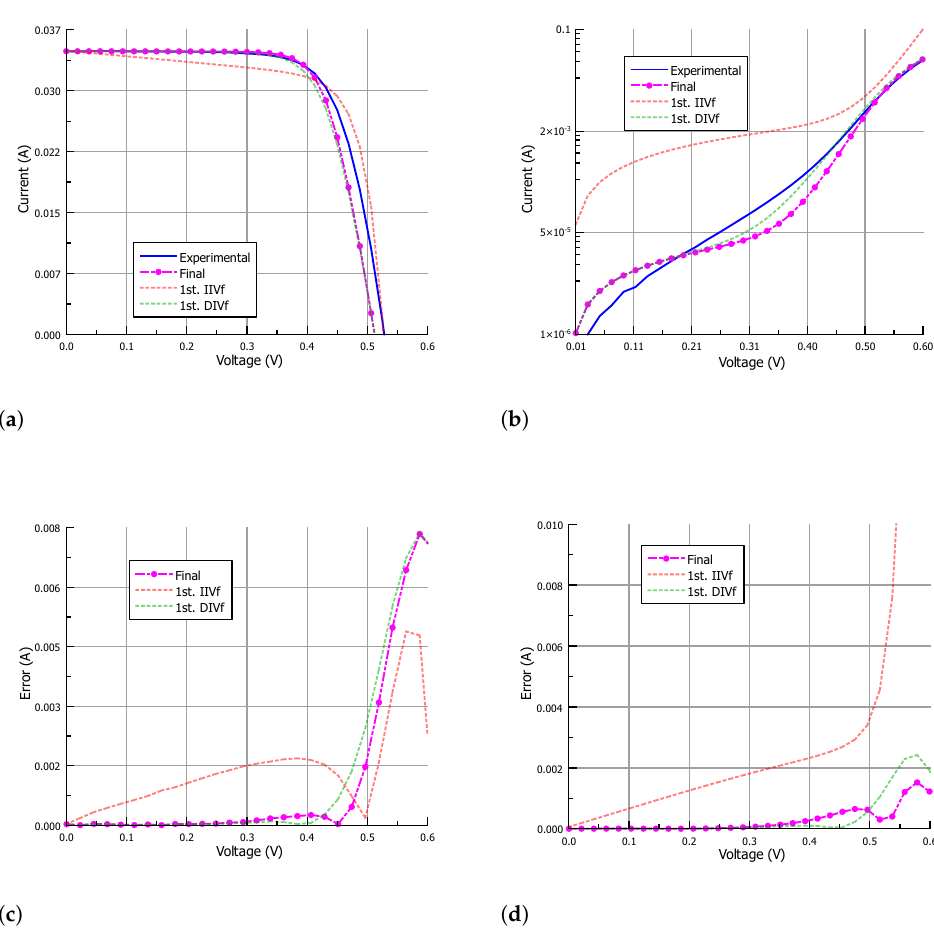
Figure 8. The I-V characteristic approximation of Cell-1 ( a ) under illumination and ( b ) in the dark; and corresponding absolute error ( c ) under illumination and ( d ) in the dark. Results are shown for parameters obtained after the first IIVf subroutine, after the first DIVf subroutine, and at the end of the parameter extraction